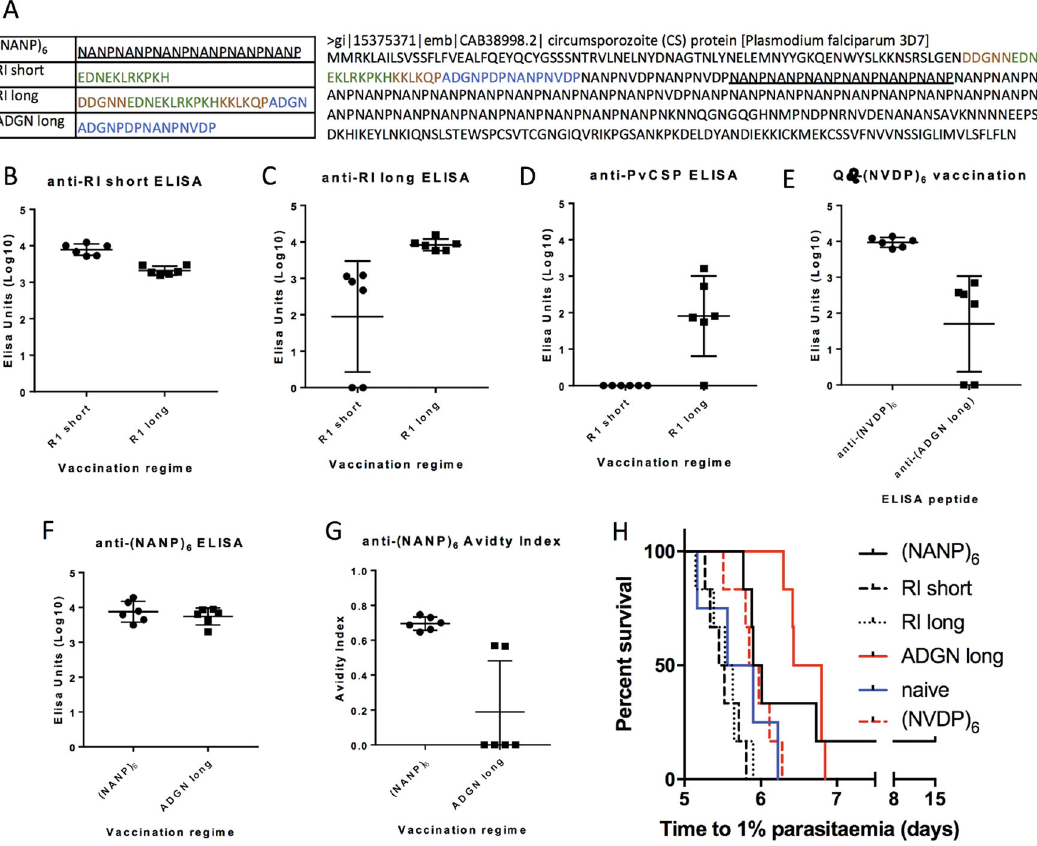
Fig. 2 Immunogenicity and protective ef fi cacy of peptides derived from PfCSP delivered as Q β -peptide vaccines. BALB/c mice ( n = 5 – 6 per group) were vaccinated with non-repeat region CSP peptides chemically coupled to Q β (3 µg per dose, by intramuscular injection, delivered with Matrix-M ™ adjuvant, three shots using 3-week intervals.) A P. falciparum CSP peptides used as Q β -peptide vaccines and location in PfCSP sequence. Standard curve ELISAs were performed using sera taken 2 weeks after the fi nal vaccination, against B “ RI short ”